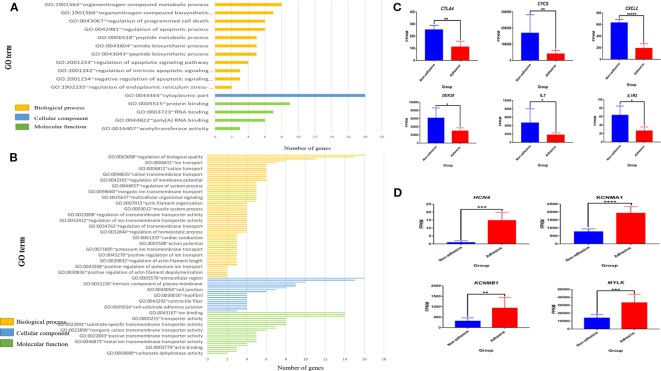
Significantly enriched (p < 0.05) GO term of differential expressed genes (DEGs) and differential expression of key genes in comparison of non-adhesive vs adhesive small intestine of large white piglets: (A) Biological process, cellular component and molecular function of the top 100 up-regulated DEGs. (B) Biological process, cellular component and molecular function of the top 100 down-regulated DEGs. (C) Down-regulated differential expressed genes associated with diarrhea susceptibility in adhesive small intestine epithelial cells using FPKM values (D) Up-regulated differential expressed genes related to immunity in non-adhesive small intestine epithelial cells using FPKM values.